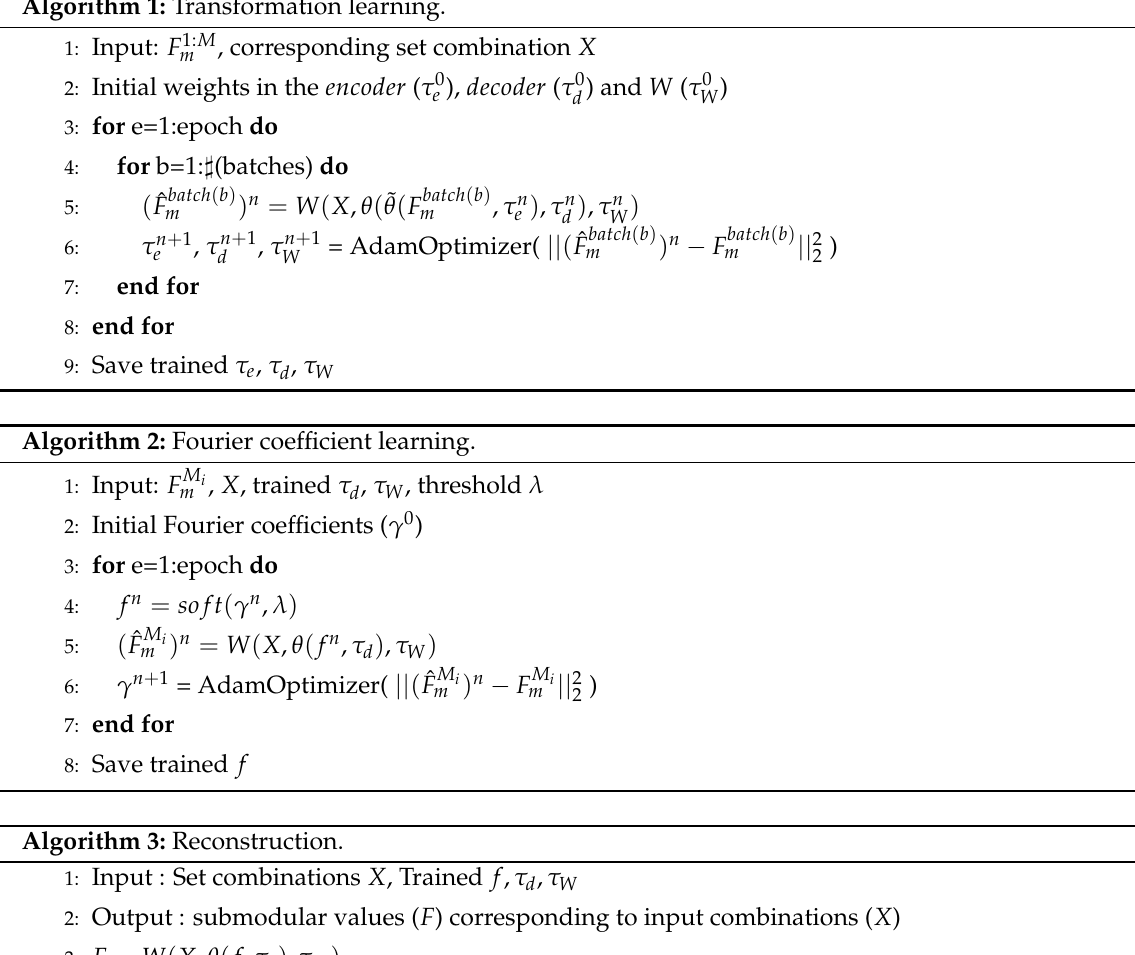
Algorithm 1: Transformation learning.